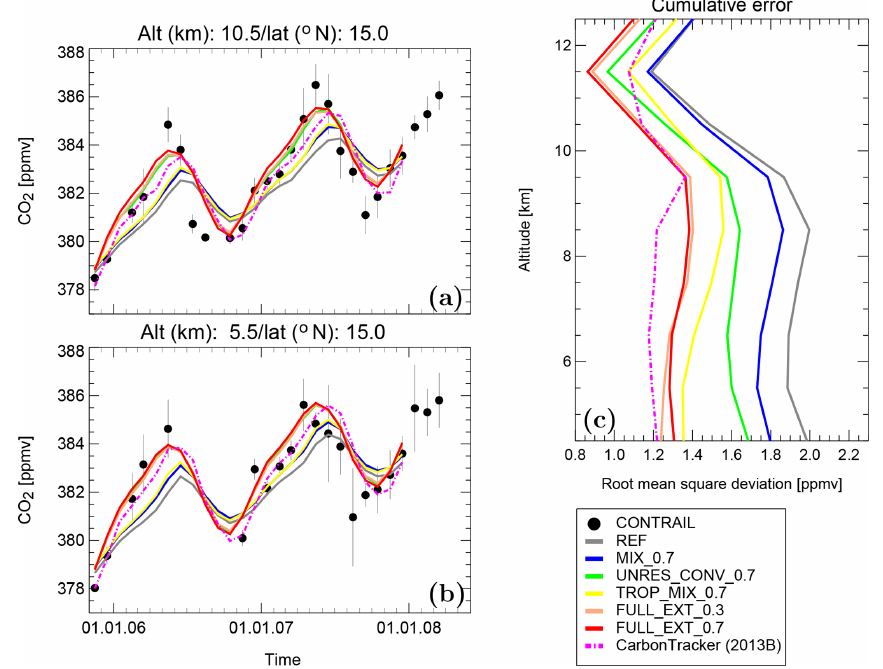
Figure 10. (a, b) Seasonality of CO 2 for CLaMS simulations compared with CONTRAIL observations (black filled circles and vertical lines denote mean values and their standard deviations, respectively) at two locations: 15 ◦ N and 5.5km (a) and 15 ◦ N and 10.5km (b) . (c) The accumulated errors in CO 2 for CLaMS simulations compared with all CONTRAIL observations as a function of the